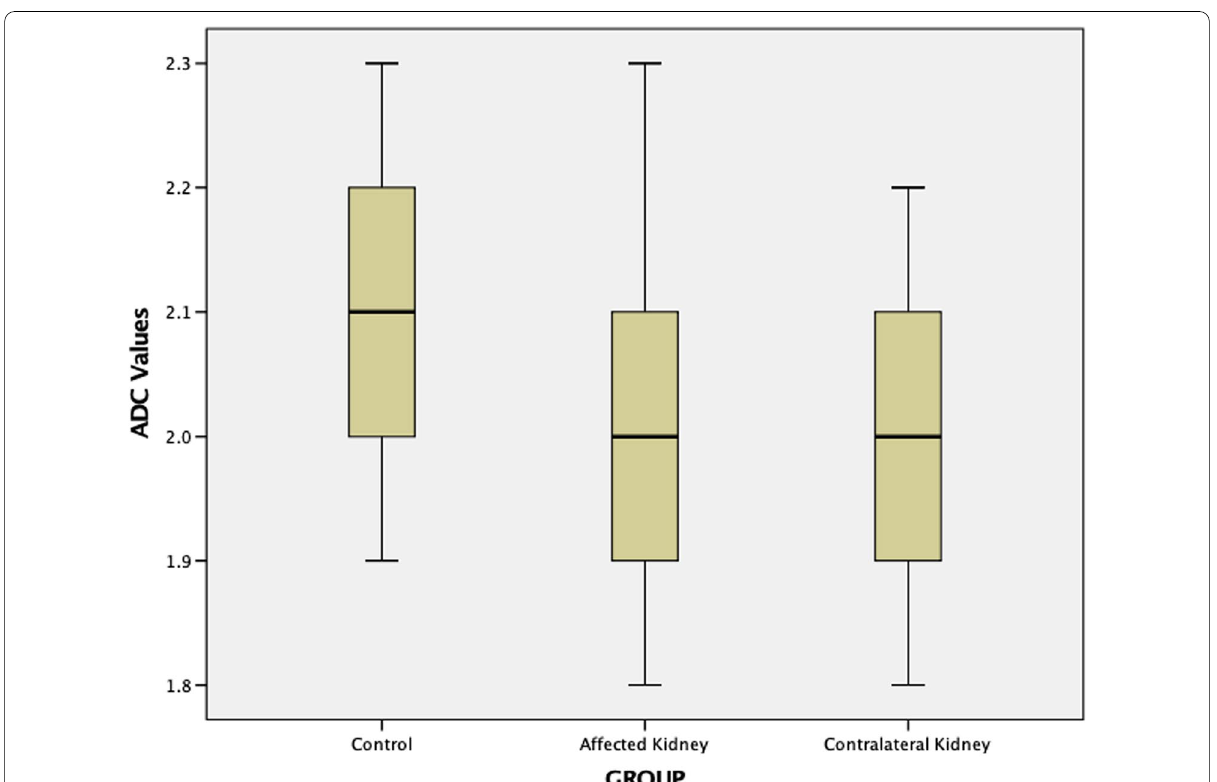
Fig. 4 Box plots of ADC (control group) ADC in, (affected kidneys) ADC in, (contralateral kidneys). For each group, the box plot indicates the mean (central horizontal line), the 75th quartile (top of box), the 25th quartile (bottom of box), there is no significant difference between ADC values of the control group and the affected kidneys, control group and contralateral kidney or between affected and contralateral kidneys of the same